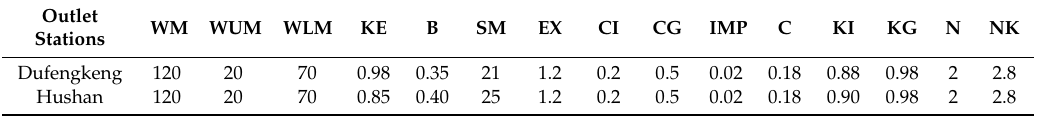
Table 4. The calibrated parameters for the Xin’anjiang model.